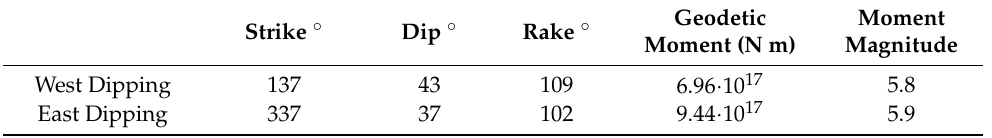
Table 5. InSAR source